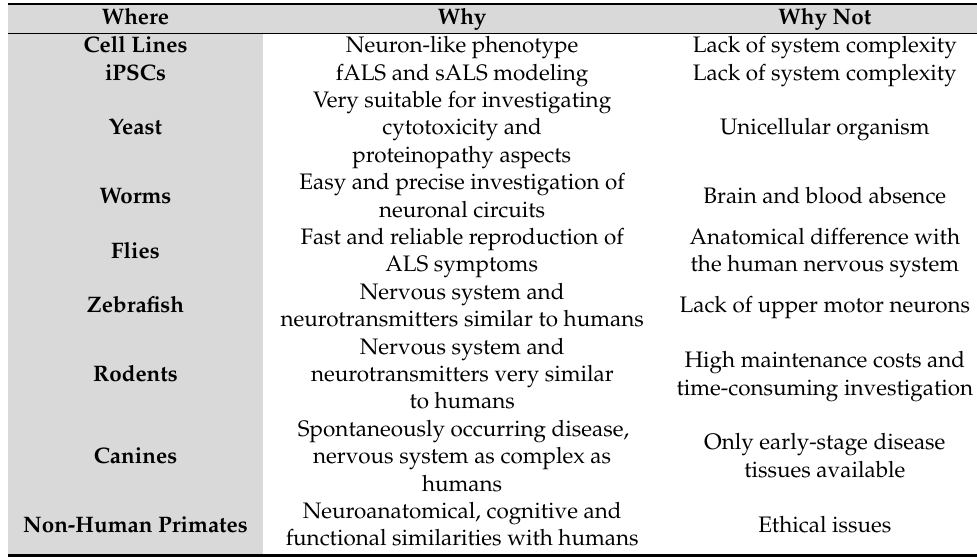
Table 1. Where and why modeling amyotrophic lateral sclerosis